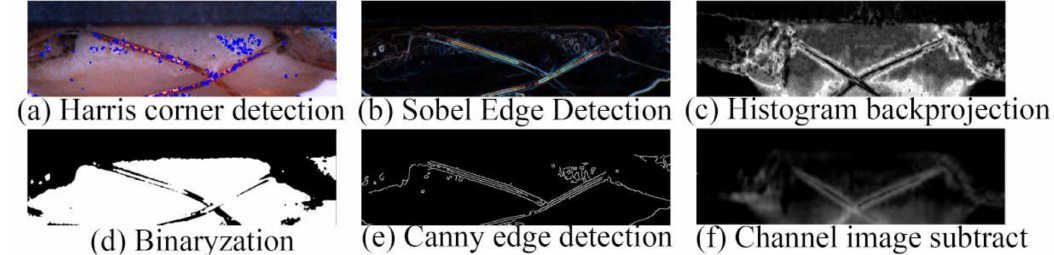
Figure 5. The feature maps extracted by traditional computer